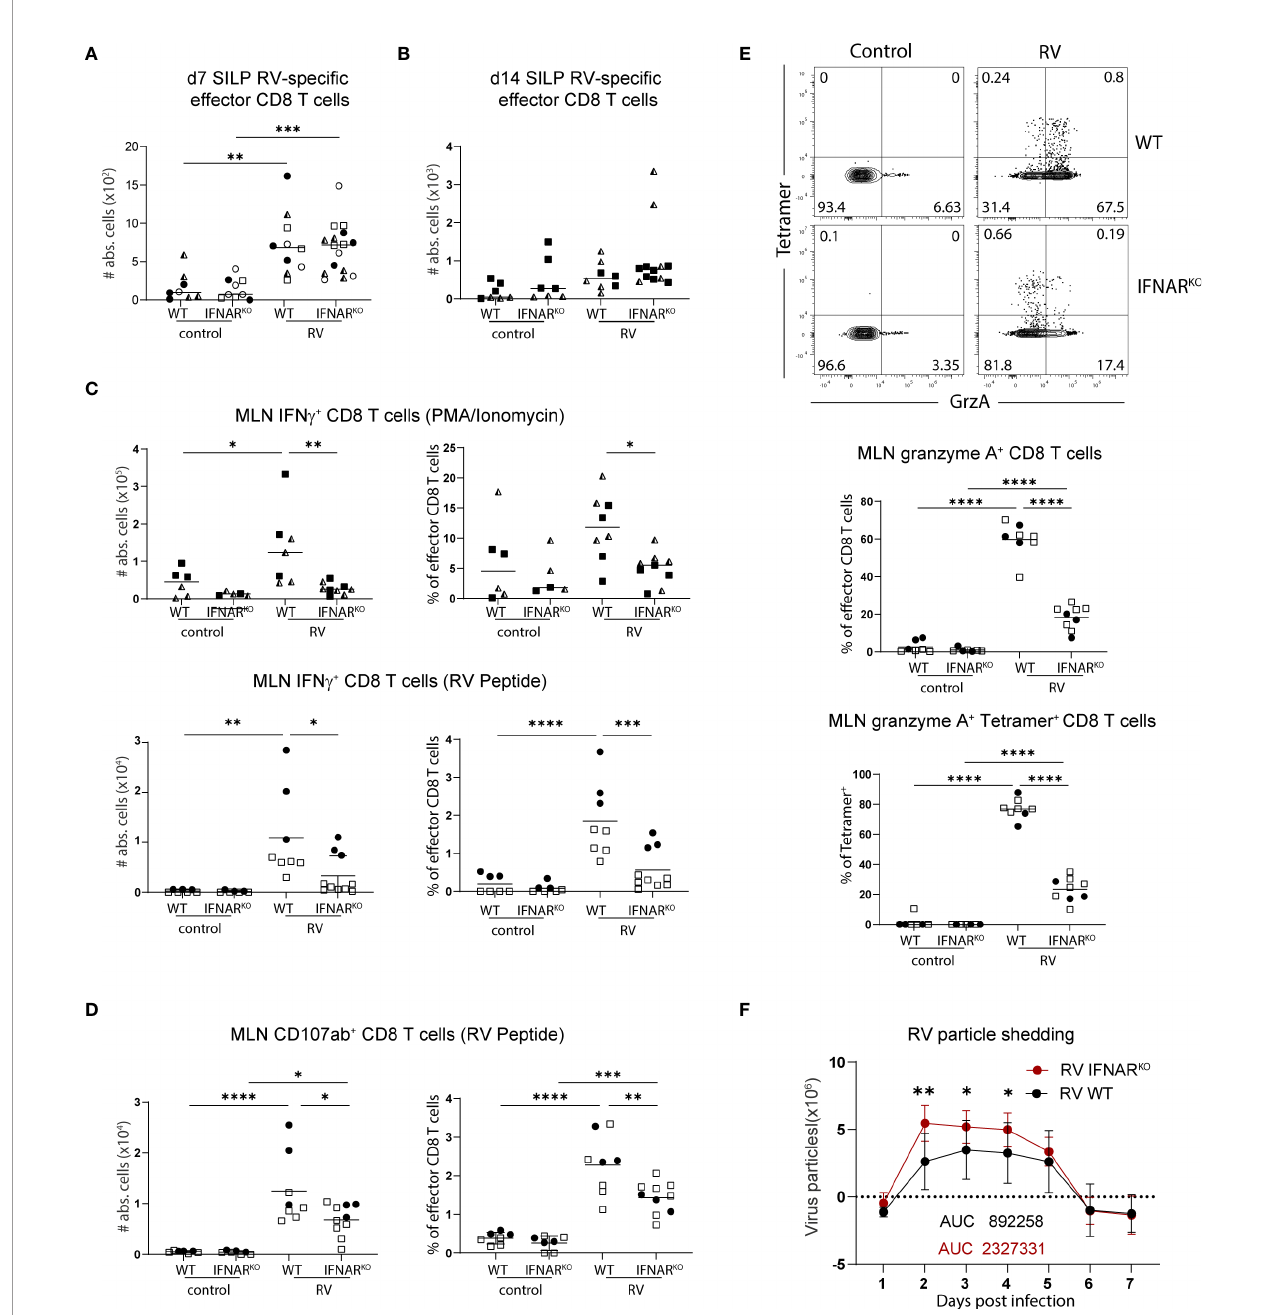
FIGURE 6 | Global de fi ciency in type I IFN signaling does not affect localisation of RV-speci fi c effector CD8 T cells but impacts IFN g expression of bulk CD8 T cells. WT and IFNAR KO mice were orally infected with RV. (A) Absolute numbers of RV-speci fi c effector CD8 T cells (CD45 + CD3 + CD4 - CD8 a + CD44 + Tet + ) from SILP seven days post infection and (B) two weeks post infection. (C) MLN cells isolated seven days post infection and restimulated with PMA/Ionomycin (top panels) and MLN cells isolated fi ve days post infection and restimulated with RV peptide (bottom panels). Absolute cell number and frequency of IFN g positive CD8 T cells (CD45 + CD3 + CD4 - CD8 a + CD44 + IFN g + ) analysed by fl ow cytometry. (D) MLN cell isolated fi ve days post infection and absolute cell number and frequency of CD107 ab positive cells (CD45 + CD3 + CD4 - CD8 a + CD44 + CD107ab + ) analysed by fl ow cytometry after RV peptide restimulation. (E) FACS plots are pre-gated on effector CD8 T cells from MLN cells isolated fi ve days post infection. Frequency of total granzyme A + (CD45 + CD3 + CD4 - CD8 a + CD44 + GranzymeA + ) amongst effector CD8 T cells and tetramer + granzyme A + cells of total tetramer + effector CD8 T cells are shown. (F) Level of RV shedding measured by ELISA on fecal samples collectedat indicated time points. (A – F) Each data point represents one mouse from a totalof two (B – E) or four (A,F) different experiments, indicated bythe different symbols. Ordinary one-way ANOVA with Tukey´s multiplecomparisontest was performed for statistical analysis. *p < 0.05, **p < 0.01, ***p < 0.001, ****p <